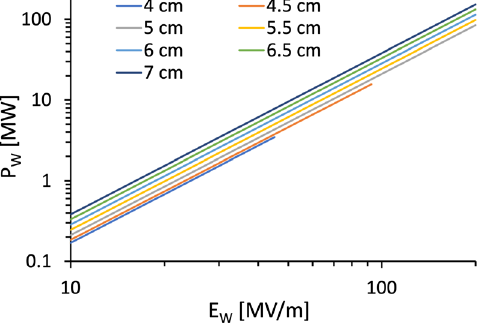
FIG. 7. Values of peak rf power P values of E , for a range of cavity radii. w